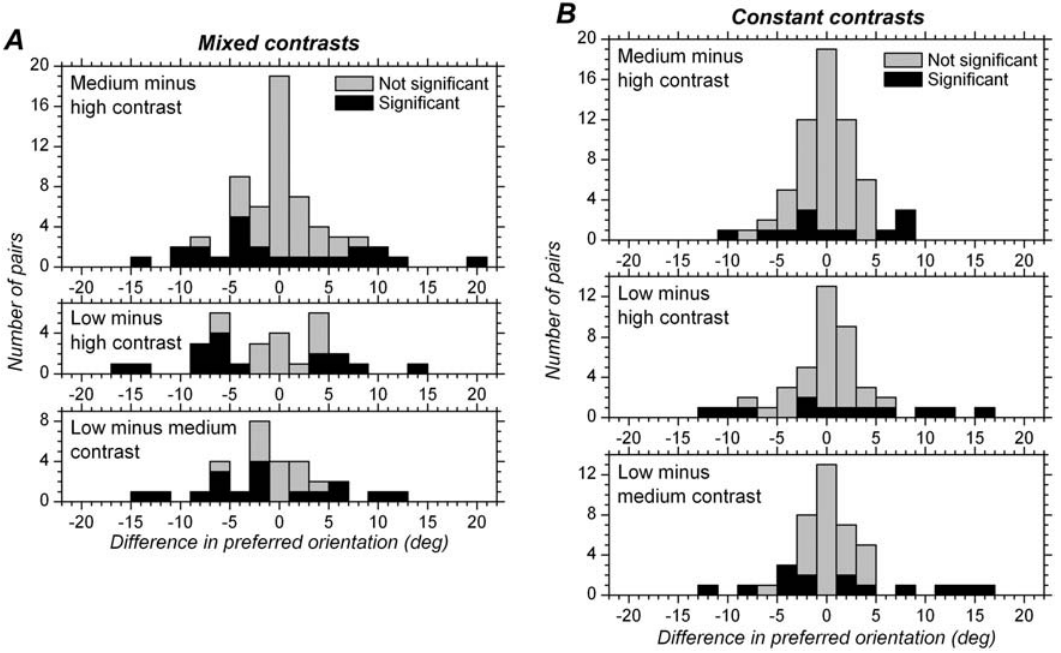
Figure 6. Distribution of differences in preferred orientation with different contrasts. A. Mixed contrasts. B. Constant contrasts. Upper histograms show the differences for medium vs. high contrast. Middle histograms show the differences for low vs. high contrast. Lower histograms show the differences for low vs. medium contrast. Black bars correspond to cases for which the difference was found to be significant at the single cell level (p , 0.05, t